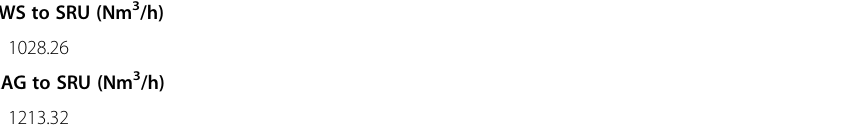
Table 5 Actual SRU dynamic units